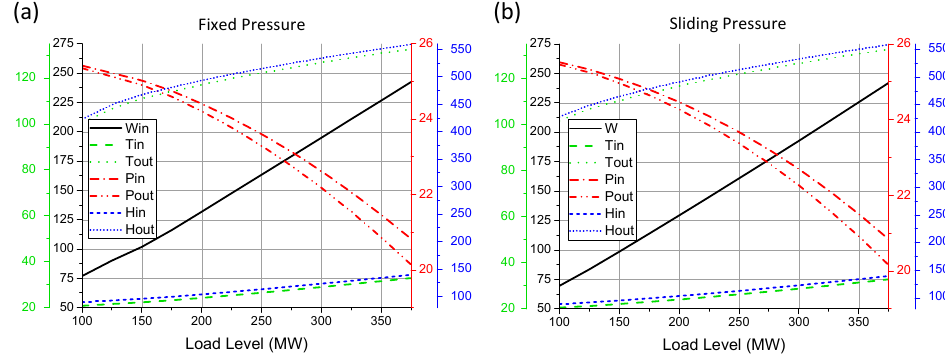
Figure 16. LPFP feedwater parameters in FP ( a ) and SP ( b ) operating mode; where, W : mass flow (kg/s); T : temperature (°C); P : pressure (bar); H : enthalpy (kJ/kg); in: inlet; out: outlet.